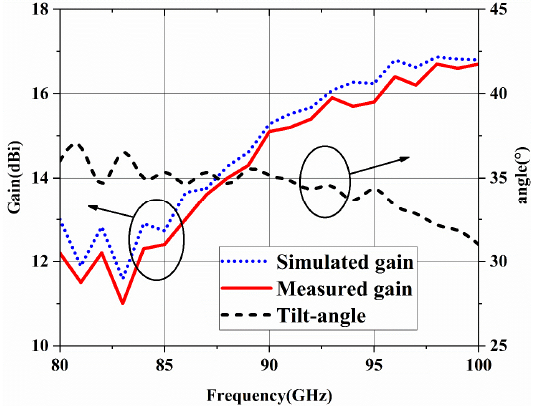
Figure 12. The peak gain and tilt ‐ angle of the proposed array.